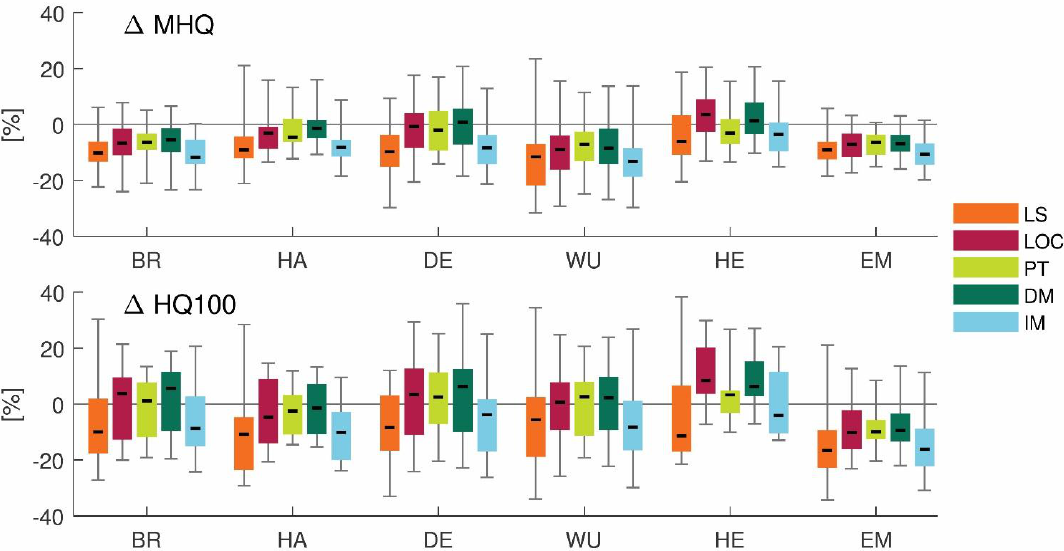
Figure 4. Percentage deviations for MHQ and HQ100 between the simulations with bias corrected climate scenario data and observed climate data for the historical period 1971–2000 for six catchments (Bramsche-BR, Harxbuettel-HA, Derneburg-DE, Wunstorf-WU, Hellwege-HE and Emlichheim-EM) applying different bias-correction (BC) methods (linear scaling (LS), local intensity scaling (LOCI), power transformation (PT), distribution mapping (DM) and Inter-Sectoral Impact-Model Intercomparison Project (ISI-MIP) approach (IM)) for precipitation and linear scaling for the other climate variables.